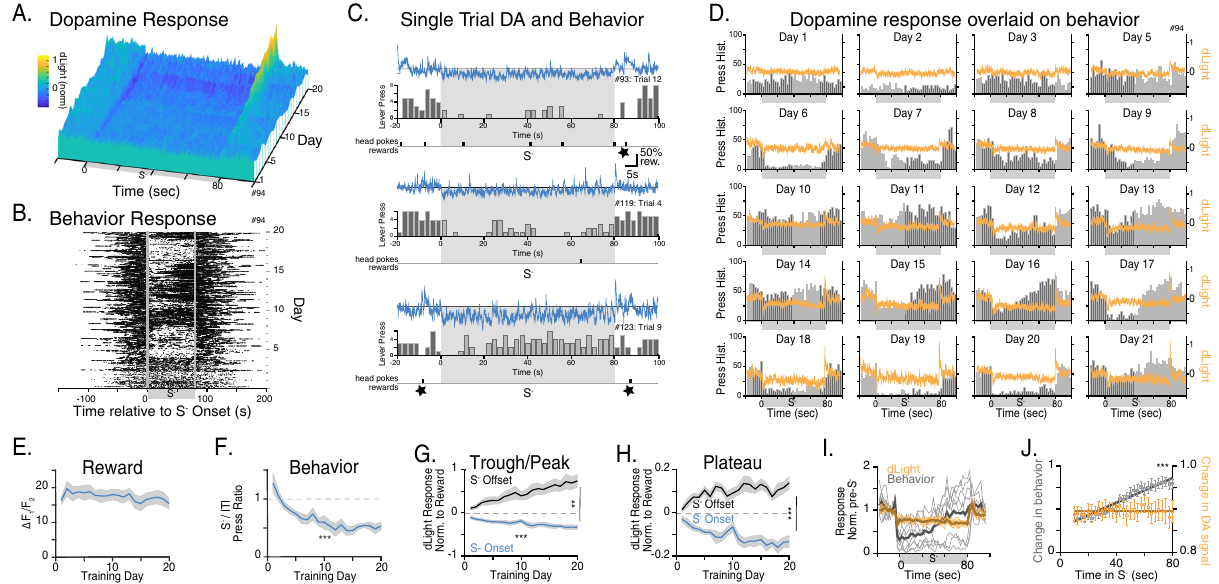
Fig. 3 Dopamine dynamics evolve with training but do not predict behavioral dynamics. A DA encoding of S − develops gradually across training days as measured with dLight in a single subject. Each day is the average of 20 trials. B Behavior changes in response to S − . Each row represents a trial. Each circle represents one lever press. C Representative dLight traces and behavior (lever presses in 2.5 s Bins) for 3 single trials from the same subject and session. D Overlay of dLight (average of 20 trials from a single session) and behavior (histogram counts of lever presses in 2.5 s bins accumulated across 20 trials) for each day of recording. E Average dLight response across subjects to reward (dipper up) across training, One-way ANOVA F (4.256, 29.79) = 1.556, P = 0.2093. F Development of behavioral response to S − , F (3.666, 25.66) = 8.988, P = 0.0002. G Development of DA transients (troughs and Peaks), two-way ANOVA: Session F (19, 133) = 5.957, P < 0.0001, tone condition F (1, 7) = 27.31, P = 0.0012. H Development of DA plateaus after S − onset (during tone) and S − offset (during ITI), two-way ANOVA: tone condition F (1, 7) = 58.17, P = 0.0001. I Comparison of behavior and dLight in 2.5 s bins for the last 6 days of training for single subject. J Within tone dynamics of behavior vs. dLight during the last 70 s in tone averaged across subjects. Best fi t of slope compared to zero (Extra Sum of Squares): change in dLight, F (1, 230) = 0.2235, p = 0.6368, change in behavior, F (1, 230) = 225.5, p < 0.0001. A – D , I Same subject, Day 4 was excluded due to poor quality recording. E – H , I N = 8 mice, gray shading or error bars represent s.e.m. Missing days due to poor recordings were fi lled in by linear interpolation. ** p < 0.01; *** p < 0.001. Source data for ( E – J ) are provided as a Source Data fi le. The raw data used to generate all other fi gures are deposited in